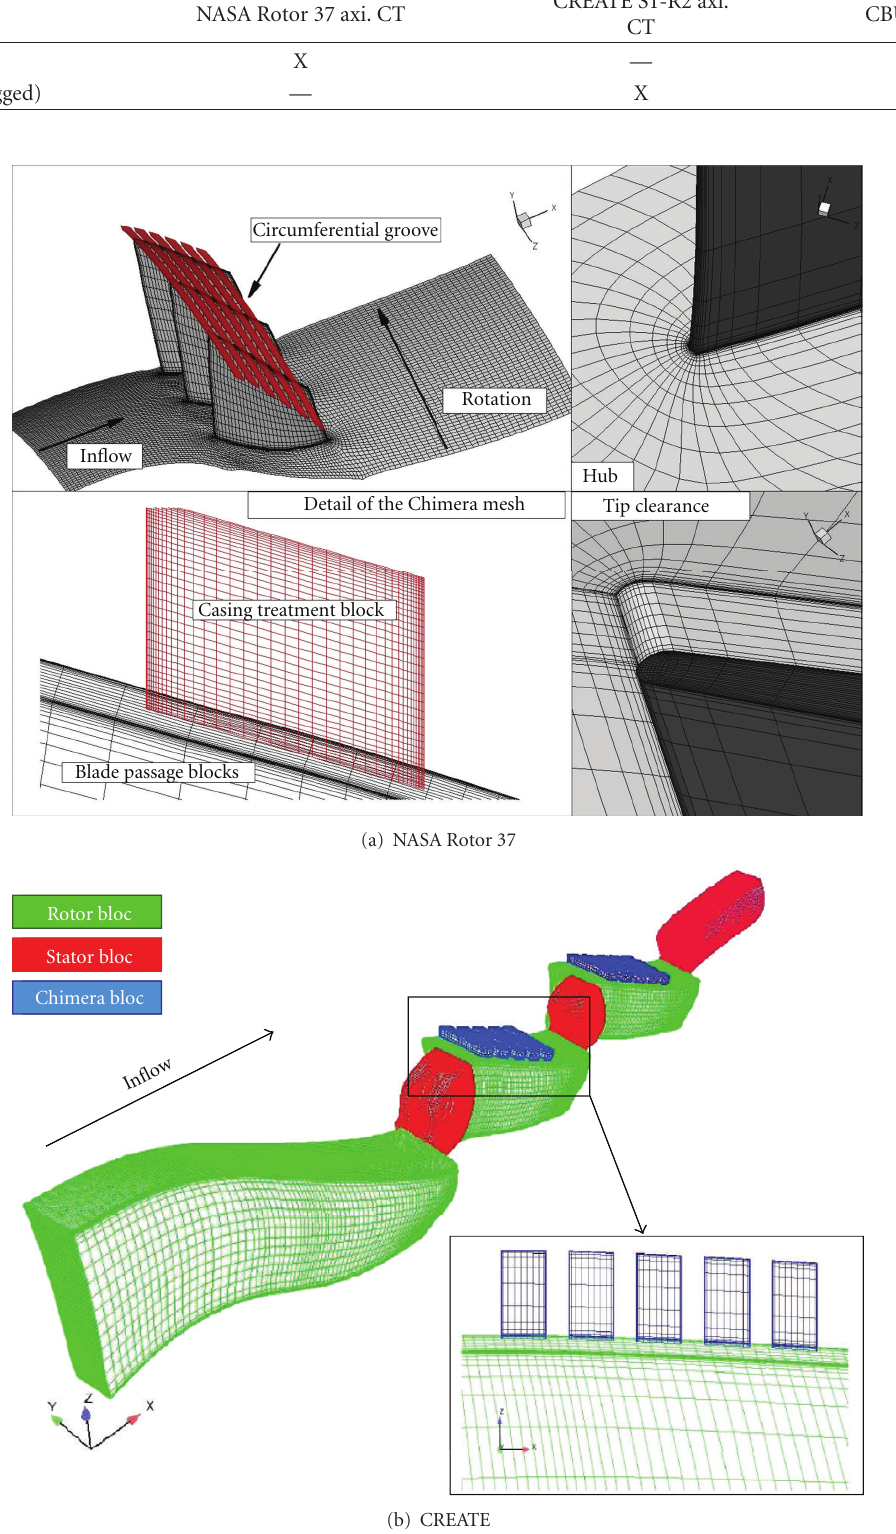
Figure 5: Chimera meshes used for modelling circumferential